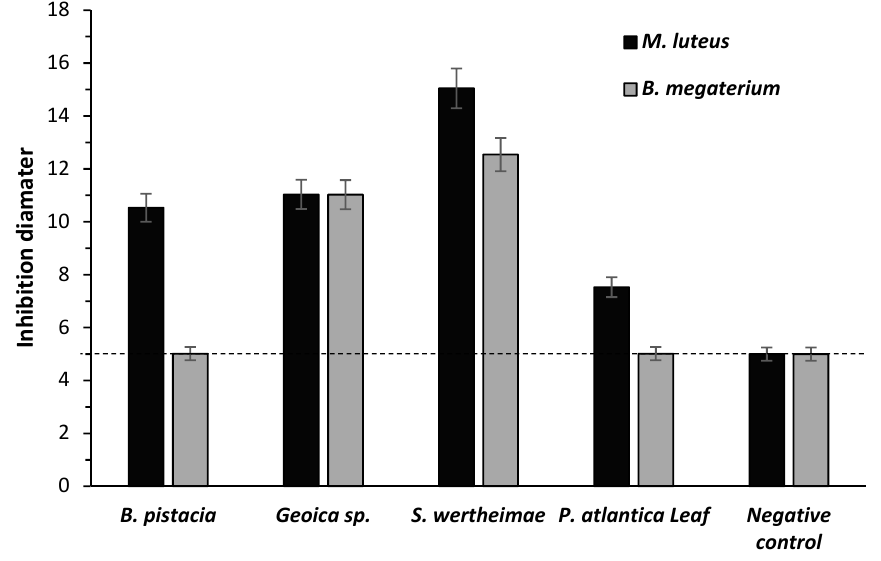
Figure 3. Well diffusion assay results. Note that 5 mm means no inhibition. Black bars are average of triplicates and error bars present one SD. Dashed line present limit of no-inhibition. Bacteria are Micrococcus luteus and Bacillus megaterium